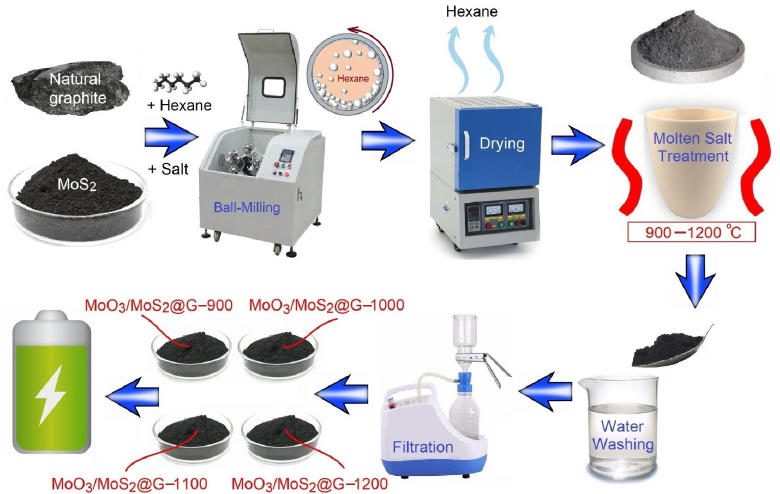
Figure 1. The process employed to convert natural graphite mineral and commercially available MoS 2 into nanostructured materials for energy-storage application.